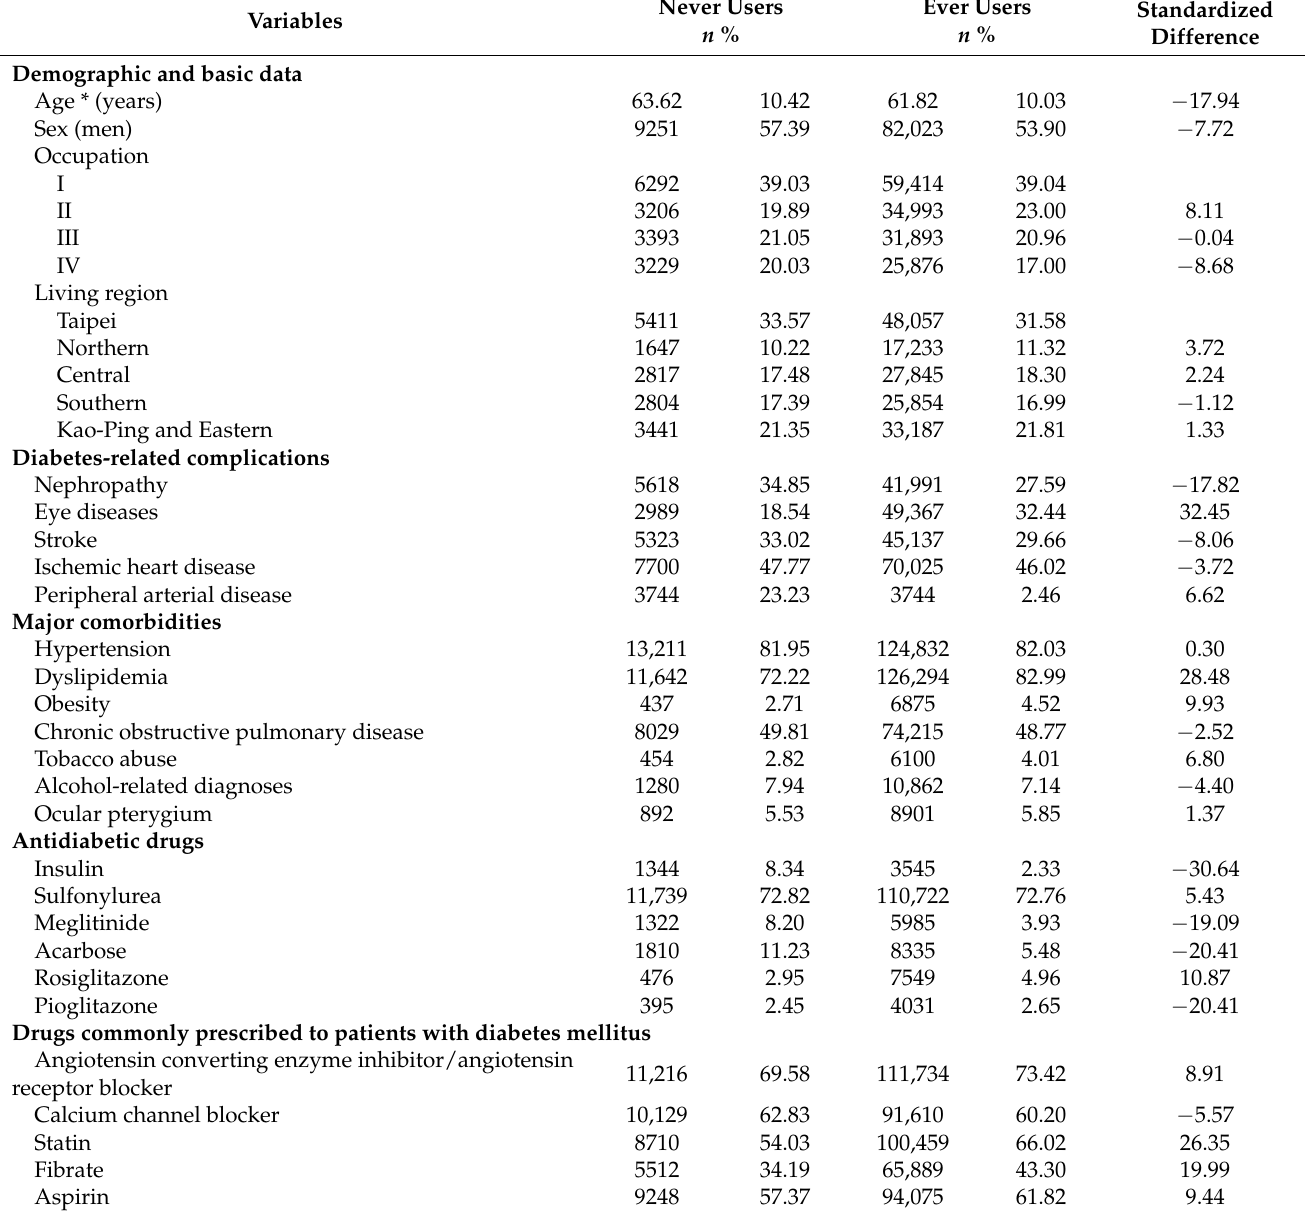
Table 1. Comparisons of characteristics between never users and ever users of